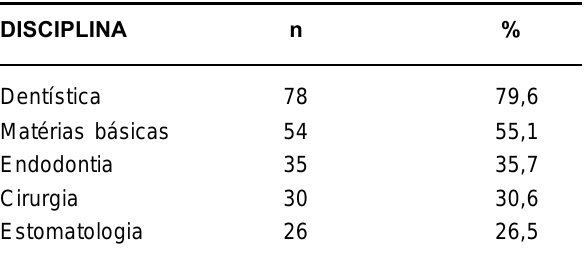
TABELA 2 - Disciplinas que foram